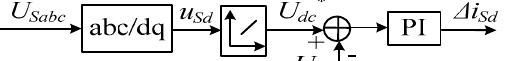
Figure 3. Reference value of DC-link voltage by droop regulator.